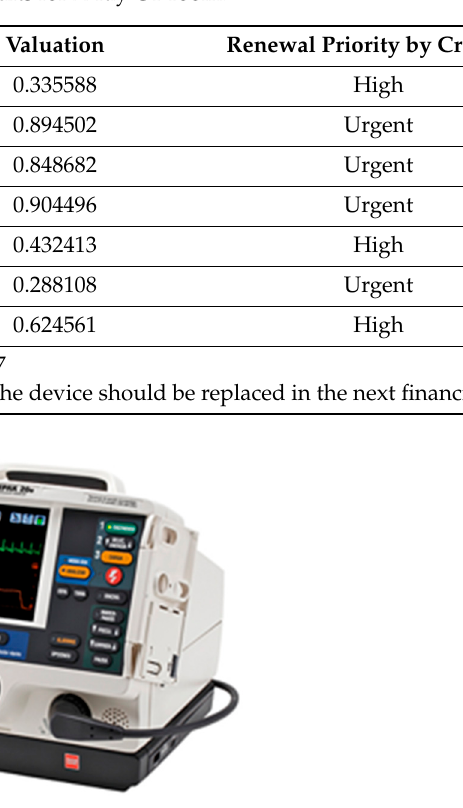
Table 25. Results for X-ray CT room.